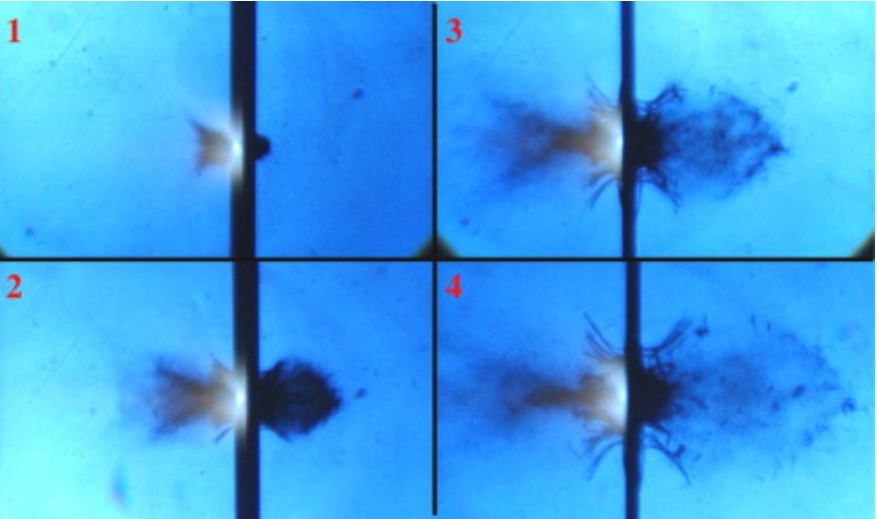
Figure 4. Frames from the video of an impact on CFRP panels. The projectile is impacting from the left; two debris clouds are generated respectively from the panel front and back faces.